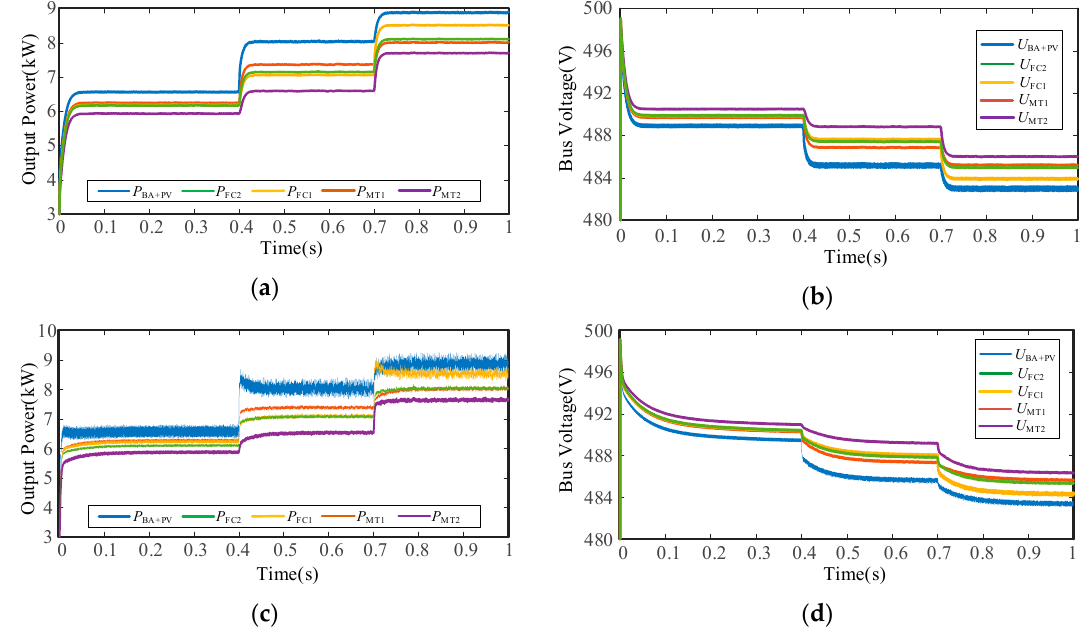
Figure 9. The comparison between the proposed droop control and the one in [35]. ( a ) the output power of each generator based on the proposed scheme; ( b ) the bus voltages based on the proposed scheme; ( c ) the output power of each generator based on the one in [35]; ( d ) the bus voltages based on the one in [35].